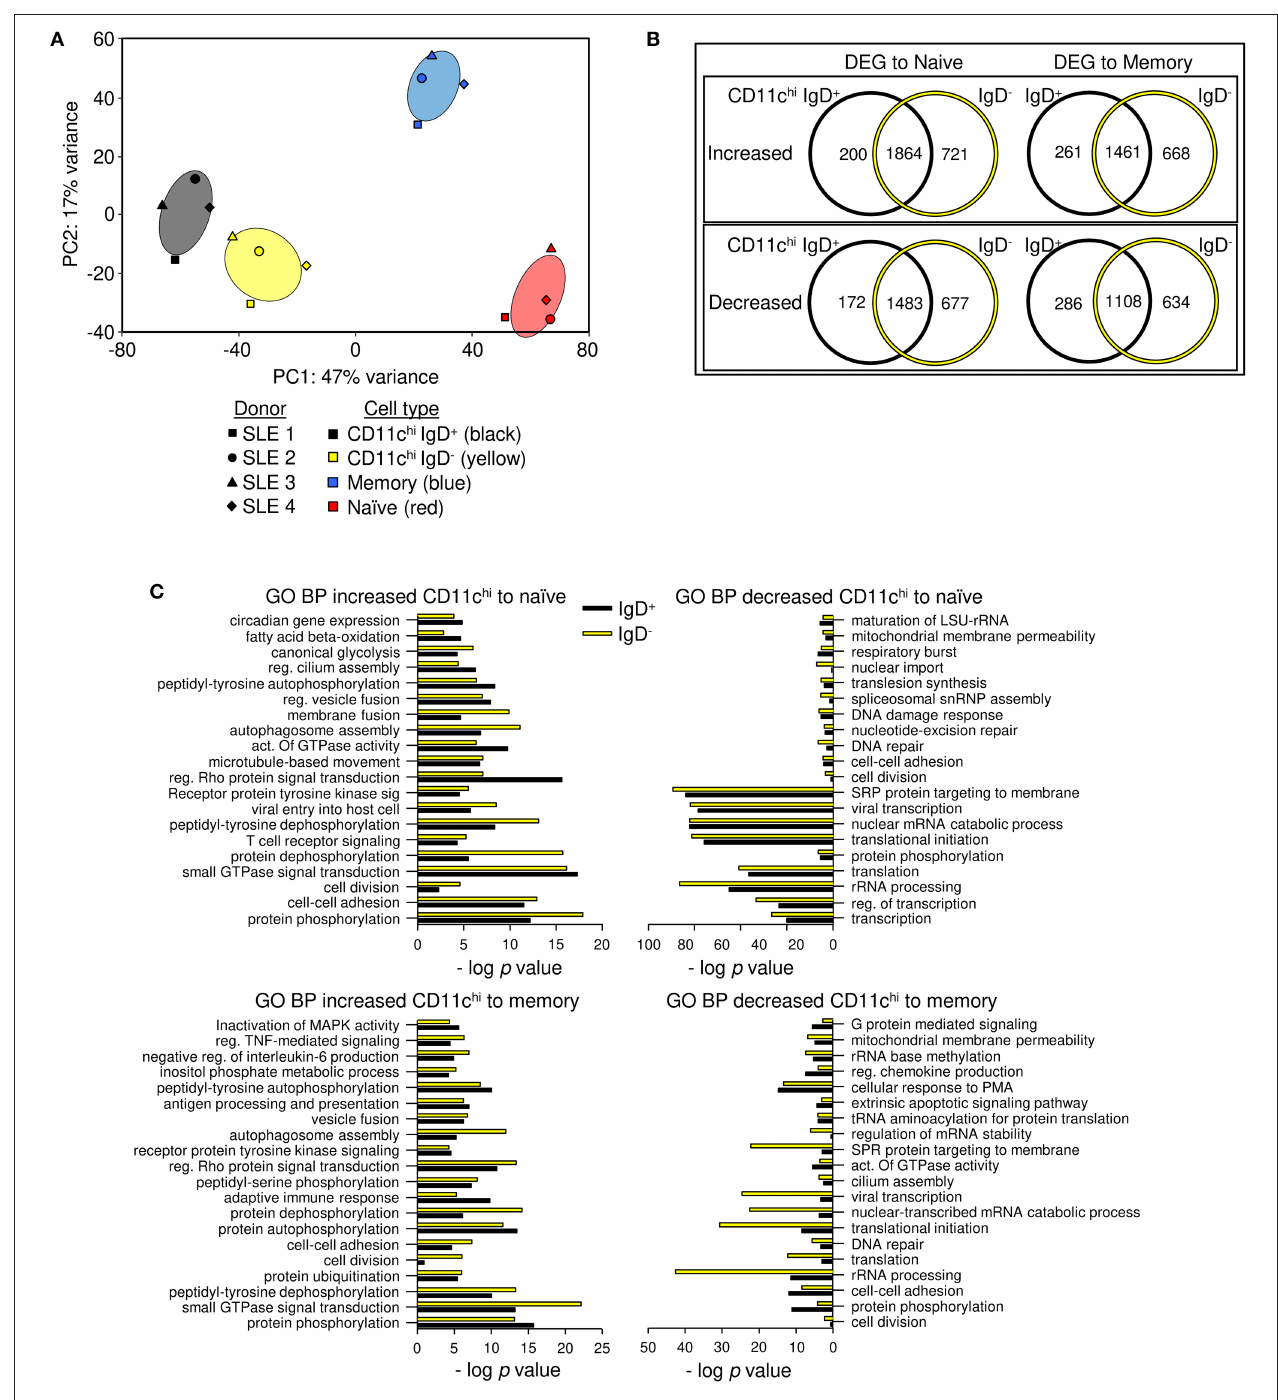
FIGURE 1 | CD11c hi -IgD + and IgD − B cells have similar gene expression and are different from memory and naïve B cells. (A) Principal component analysis of CD19 + CD11c hi IgD + CD27 − (black), CD19 + CD11c hi IgD − CD27 − (yellow), CD19 + IgD − CD27 + (memory, blue), and CD19 + IgD + CD27 − (naïve, red) B cells. Ellipses demonstrate the 95% confidence intervals. (B) Limma DEG analysis was done separately for CD11c hi IgD + and CD11c hi IgD − compared to either naïve or memory B cells (FDR < 0.05). Genes are listed in Supplementary Data File 3 . (C) GO BP analysis was used to determine functional enrichment of increased or decreased transcripts. Pathways with the lowest p -values are graphed by -log p value. Complete list of GO BP and genes in each pathway are in Supplementary Data File 6 .